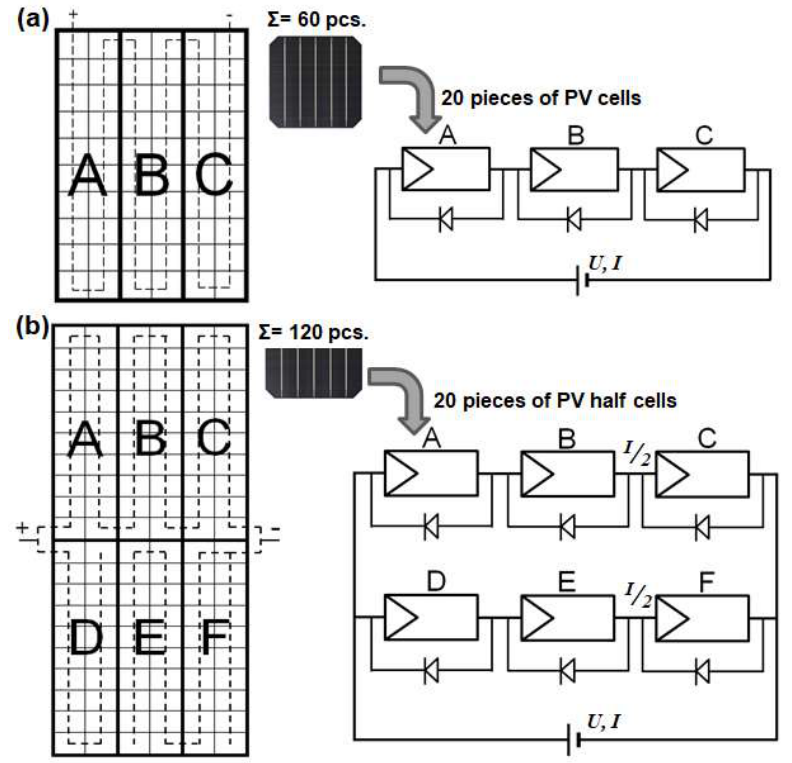
Figure 1. Construction diagram of two types of photovoltaic (PV) modules: ( a ) classic built of 60 whole cells and ( b ) built of 120 half-cells.